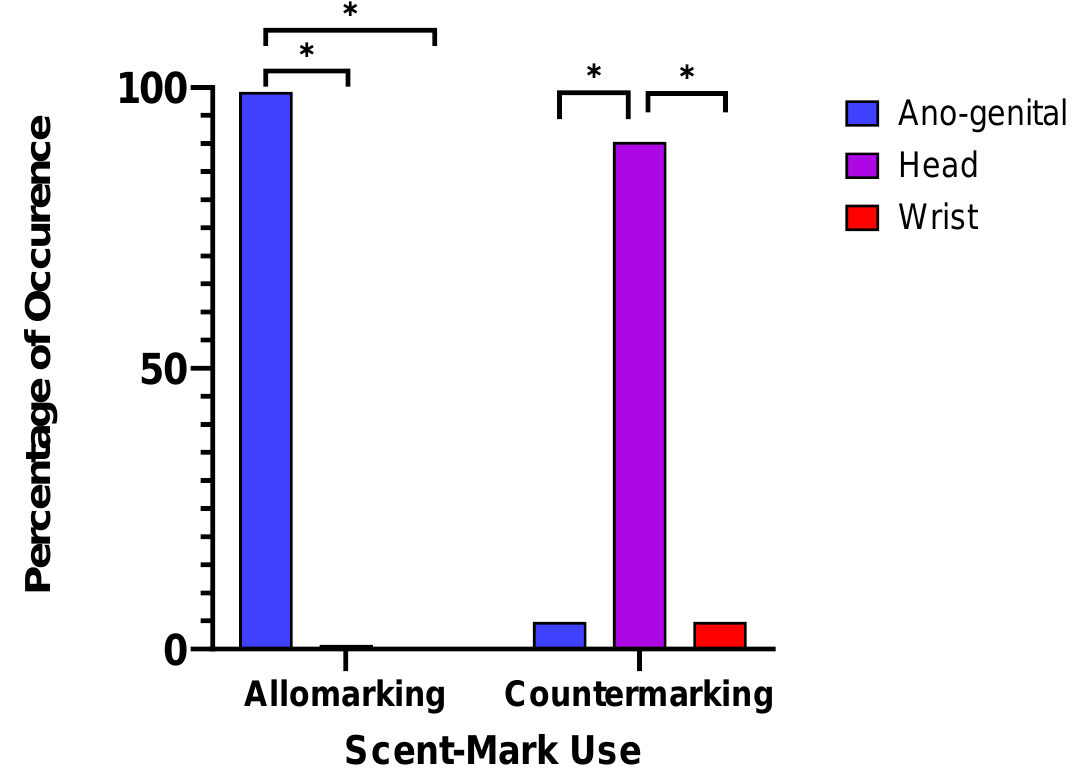
Figure 3. Percentages of occurrence for male allomarking and countermarking associated with scent-mark type. A * indicates where significant differences between the scent-mark types were found.